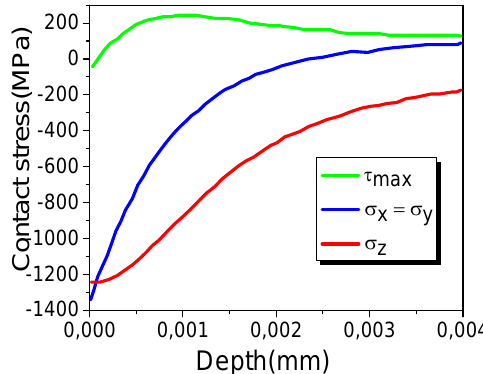
Figure 1. Shear stress distribution for the carbide coating of vanadium–chromium deposited on AISI D2 steel.